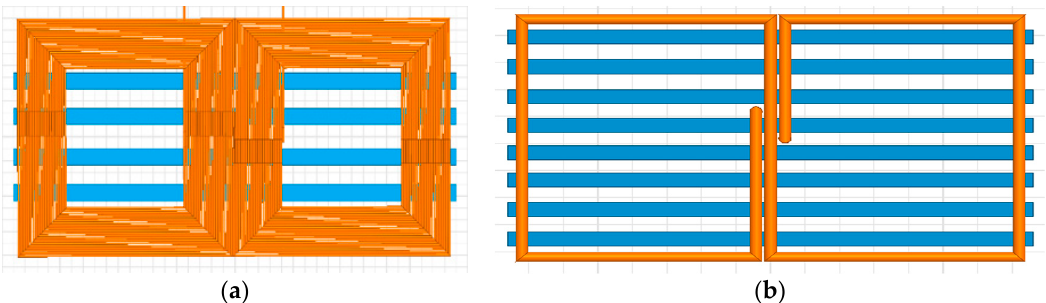
Figure 12. First model of the DD pad designed ( a ) and its simplified counterpart used for the simulations ( b ).